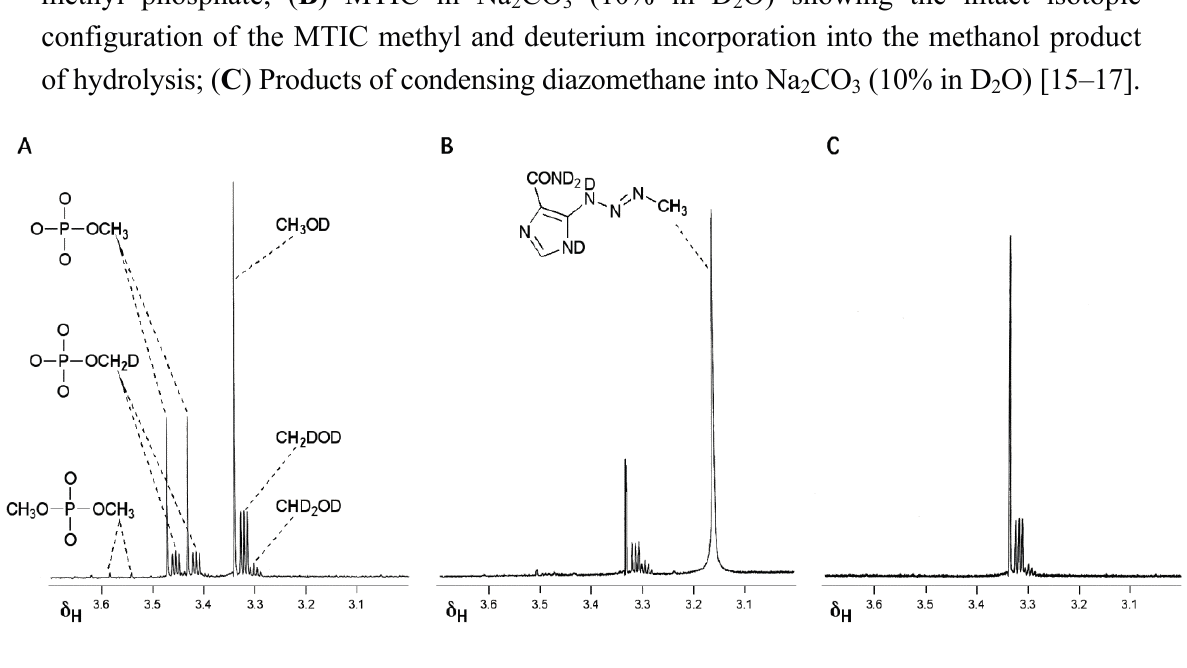
Figure 1. Reaction of TMZ, MTIC and CH TMZ with phosphate buffer pD = 7.8 showing deuterium incorporation into methanol and methyl phosphate; ( B ) MTIC in Na configuration of the MTIC methyl and deuterium incorporation into the methanol product of hydrolysis; ( C ) Products of condensing diazomethane into Na